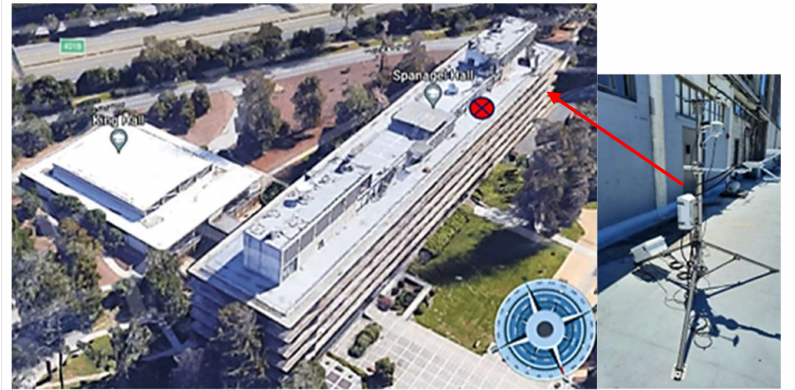
Figure 1. The NPS experimental site with the exact location of the sensors.